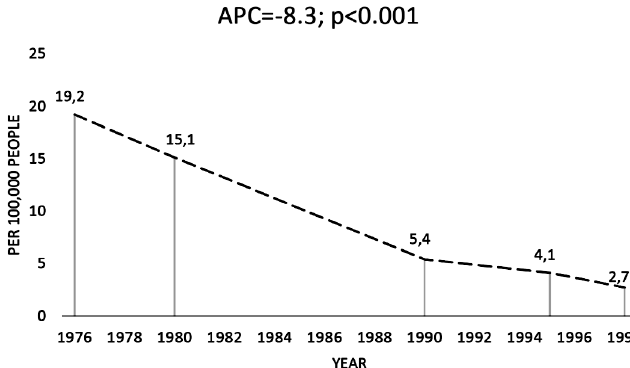
Figure 6. Syphilis incidence rates in the years 1976–1998 In the years 1998–2007 (Figure 7), a further modest decrease in the number of syphilis cases, at a level of almost 3% a year ( AP C = − 2 . 7 , p = 0 . 107 ). The change in this level was not statistically significant. The ap- parently stable level of syphilis incidence might suggest that the epidemi- ological situation had been contained. It should be remembered, however, that the years in question brought the administrative and healthcare re- forms in Poland. Many practices and dermal-STD outpatient clinics were closed down and the system of epidemiological surveillance practically col- lapsed. Due to the need for finding savings, the number of syphilis screening tests periodically performed in certain professions decreased